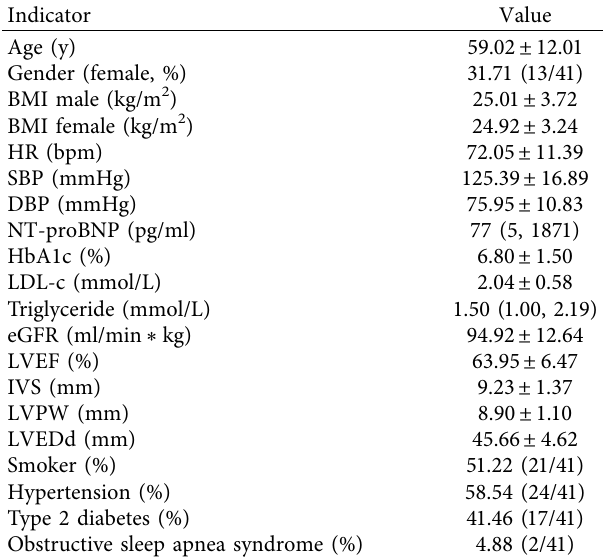
Table 1: General data of patients